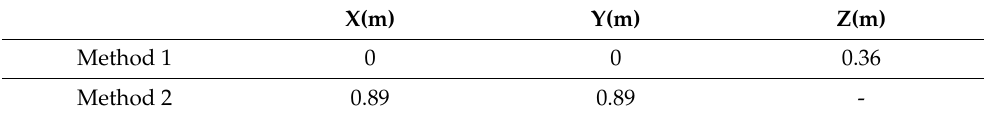
Table 1. Central coordinate estimation results of two